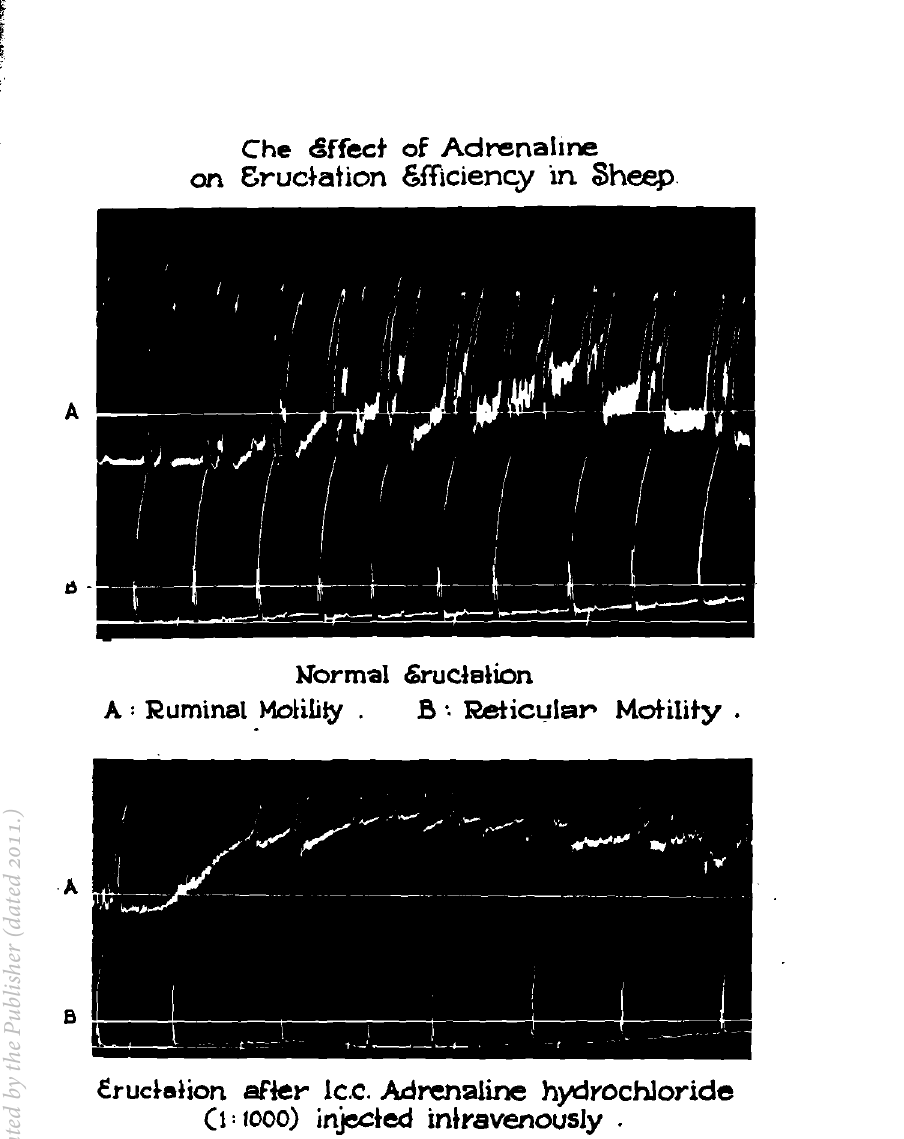
Fig. 14. (Weiss, 1953) Histamine. The administration of histamine causes paralysis of the rumen and reticulum with marked inefficiency of